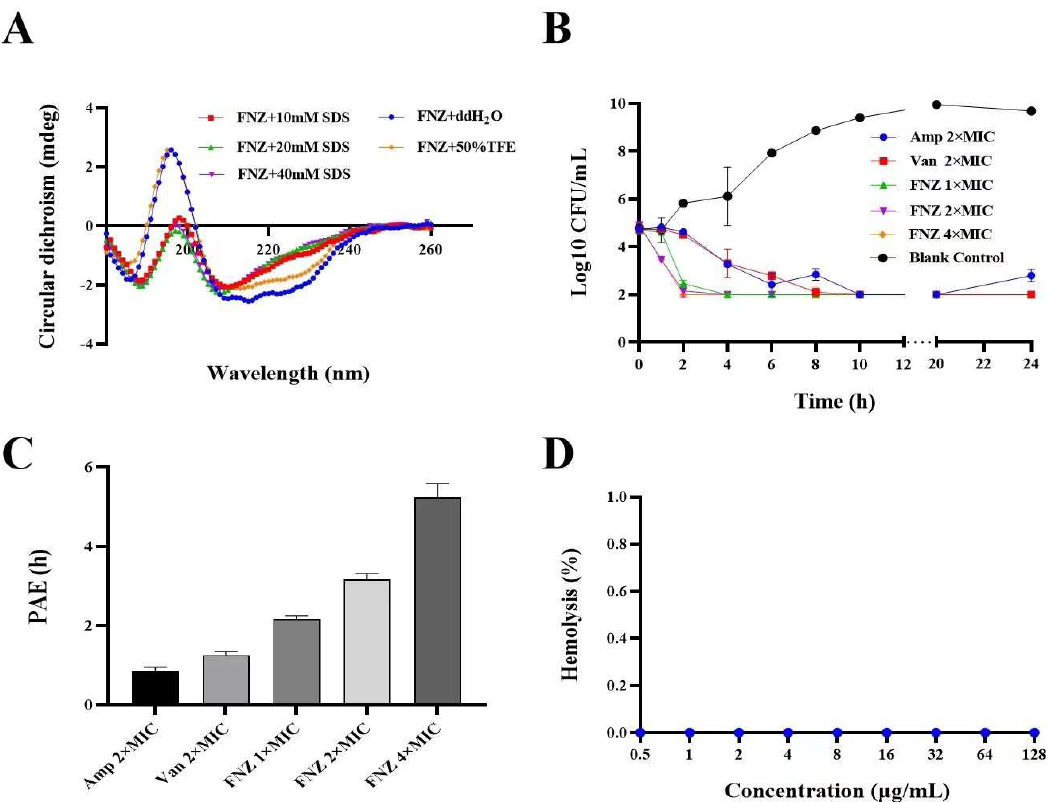
Figure 6. Antimicrobial characteristic of FNZ. ( A ) CD spectra of FNZ in water, SDS, and 50% TFE; ( B ) Time-killing curves of FNZ (1×, 2×, or 4× MIC) against S. aureus ATCC 43300; ( C ) The PAE assay of FNZ against S. aureus ATCC 43300. ( D ) Hemolytic activity of FNZ at different concentrations (0.5–128 µ g/mL) against mouse erythrocytes. Amp: ampicillin, Van: vancomycin. The results are given as the mean ± SD ( n = 3). Table 1. Antibacterial spectrum of the